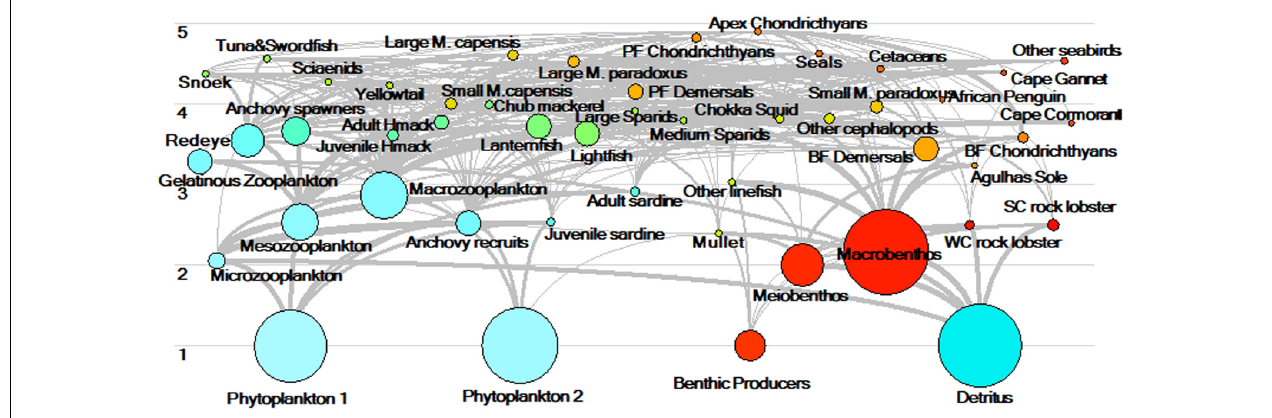
FIGURE 4 | Schematic of the trophic flows through the Southern Benguela food web estimated for 1978. Circles representing functional groups and are proportionally scaled according to biomass in